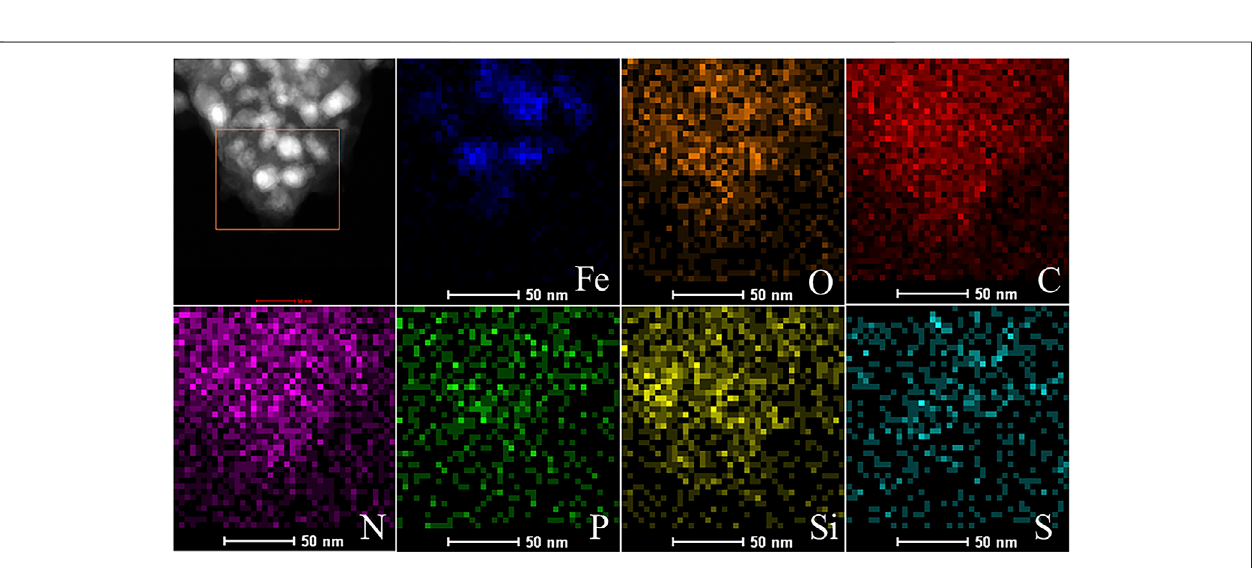
( Figure 2B ), it can be observed that Fe nanoparticles with a size of